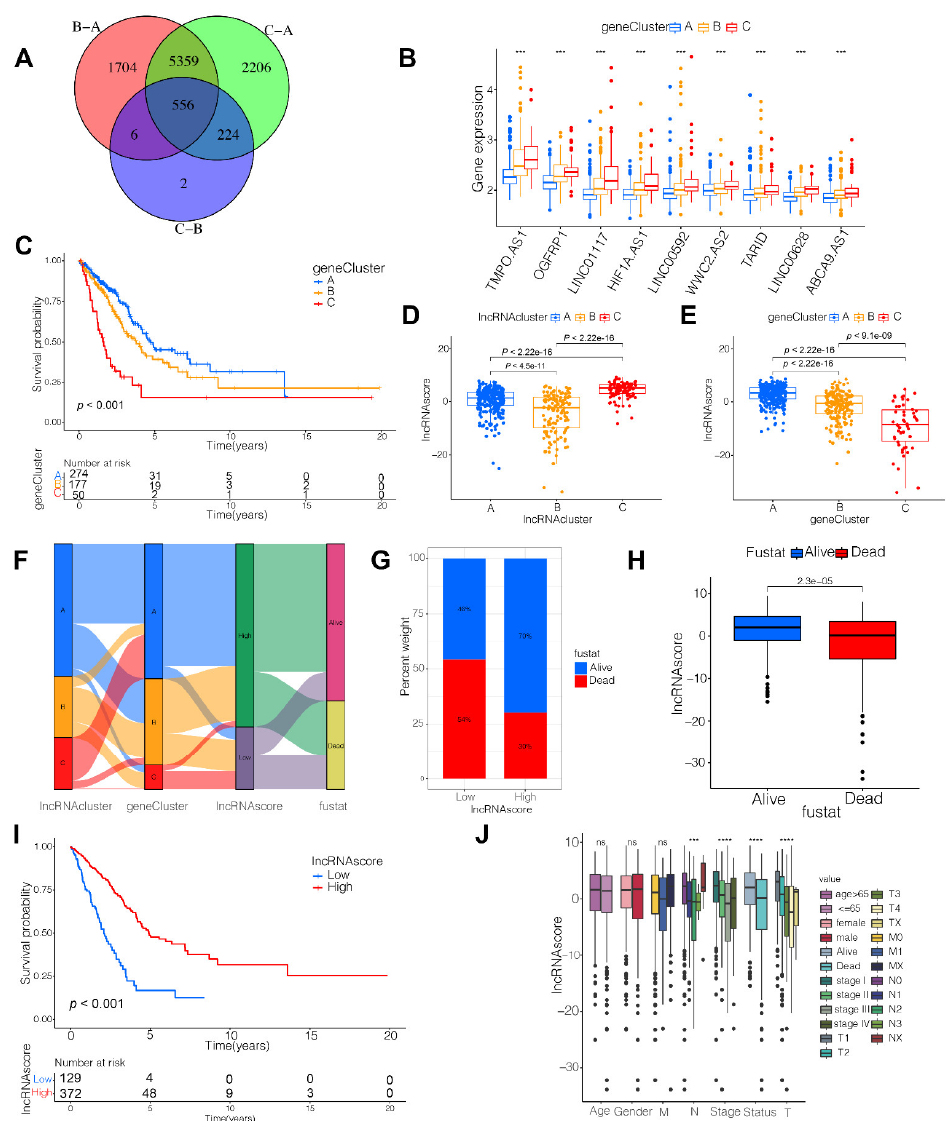
Figure 3. Construction of lncRNA score and the prognostic values of lncRNA score. ( A ) A total of 556 lncRNA cluster-related genes shown in Venn diagram; ( B ) Levels of 9 hub lncRNAs in the three gene clusters; ( C ) Kaplan–Meier curves of survival in the TCGA-LUAD ( n = 501) cohort with three distinct gene clusters; LncRNA score in distinct ( D ) lncRNA clusters and ( E ) gene clusters; ( F ) Alluvial diagram showing the changes in lncRNA clusters, gene clusters and lncRNA scores; ( G ) Proportion of survival and death in the high and low lncRNA score groups; ( H ) Comparison of the lncRNA score in alive versus dead patients; ( I ) Kaplan–Meier curves of survival in the high and low lncRNA score groups; ( J ) Difference in lncRNA score among distinct clinical subgroups in LUAD cohort. *** p < 0.001, **** p < 0.0001, ns, not